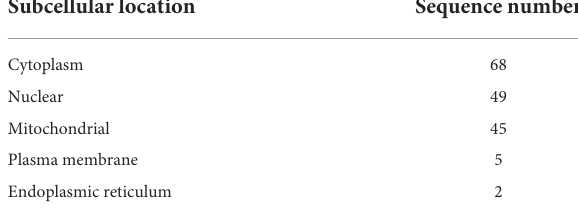
TABLE 2 The subcellular localization of DEAPs.